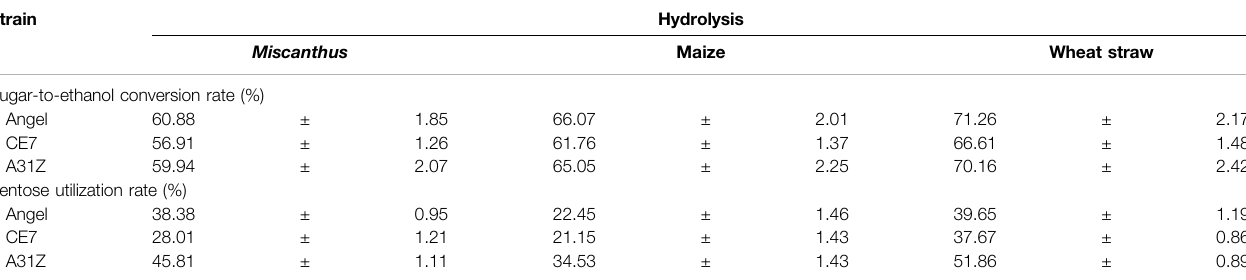
TABLE 2 | Sugar-ethanol conversion rate (%) and pentose utilization rate (%) of different yeast using the hydrolysis of Miscanthus , maize, and wheat straw.